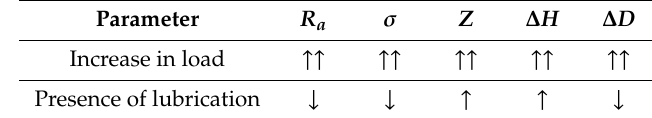
Table 3. Summary of the results.